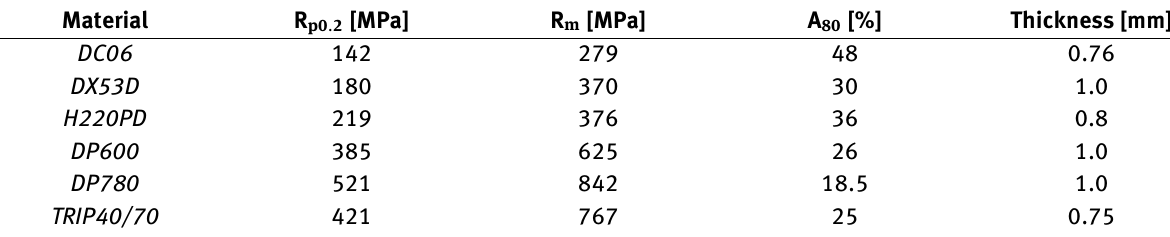
Figure 3: Sample for tensile test. Table 1: Basic mechanical properties of joined steel sheets.